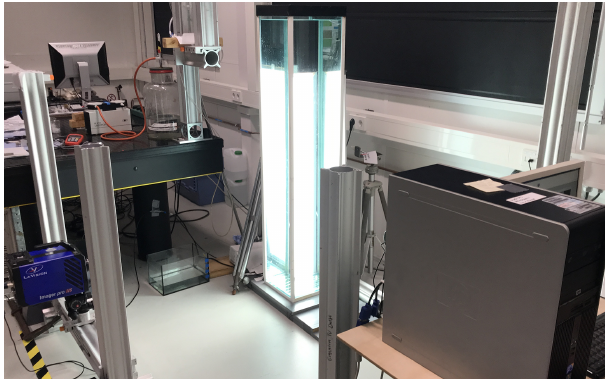
Figure 2. Experimental pilot set-up ( D = 300mm) at the Delft Uni- versity of Technology (TU Delft) to determine particle 3D path tra- jectories in a quiescent fluid with high-speed